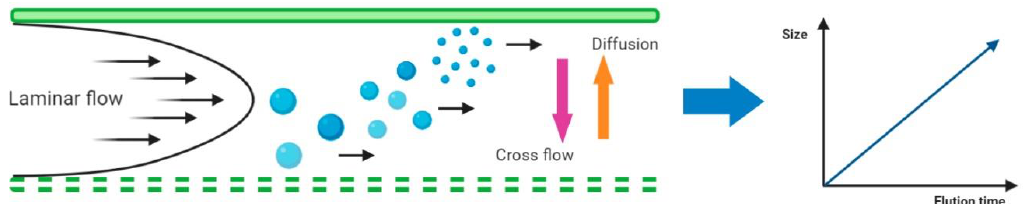
Figure 5. Asymmetrical-flow field-flow fractionation (AF4) channel cross section showing the separation principle (adapted from [52]). Elution occurs by means of a laminar flow in parabolic pattern. A cross flow drives the particles towards the membrane, and is counteracted by the size-related diffusion properties of the particles.